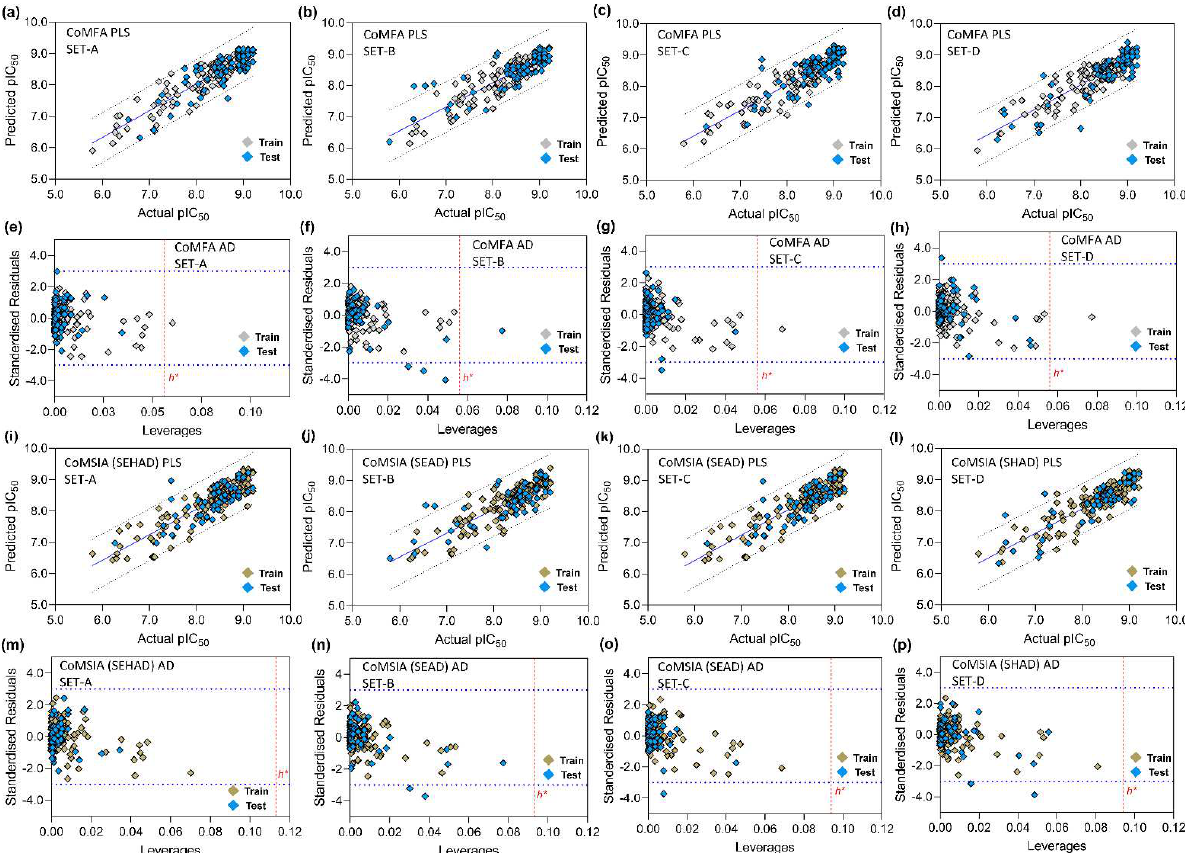
Figure 6. PLS correlation plot and Williams plot analysis of CoMFA and CoMSIA models. ( a – d ) are the PLS plots, and ( e – h ) are the corresponding Williams plots of the different test set groups (SET-A, SET-B, SET-C, and SET-D), respectively, in the CoMFA scheme. Similarly, ( i – l ) are PLS plots, and ( m – p ) are the corresponding Williams plots for the AD analysis of different test set groups in the CoMSIA scheme. The warning leverage (h*) is shown by dotted red lines inside the AD plots. The actual vs. predicted pIC 50 values corresponding to the training set and test set compounds are depicted in gray and cyan in the CoMFA scheme. In the CoMSIA scheme, the values of the training and test set compounds are colored in light brown and cyan, respectively.